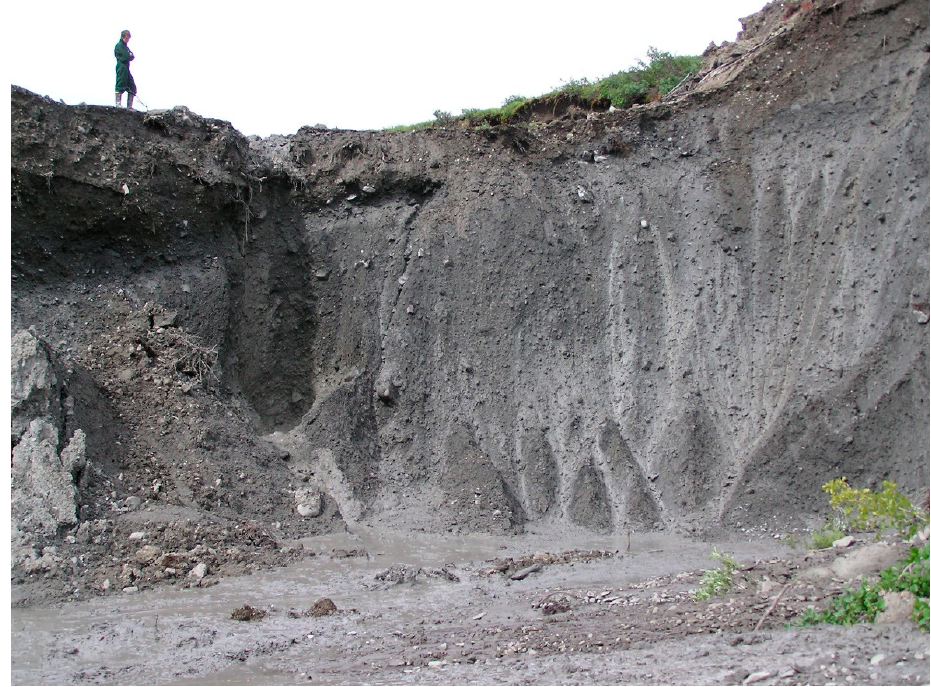
Figure 6. Exposure of the main scarp in slump NOAT265. The poorly sorted sediment in this exposure lacked obvious massive ice, but it contained enough ice to produce a zone of saturated mud at its base. Relict Pleistocene glacial ice has been observed in thaw slump escarpments at multiple locations in the Noatak Valley [13,14]. The total area of Pleistocene glacial drift mapped in the Noatak Valley [35,49] is about 2900 km 2 . Ice-cored glacial terrain is particularly vulnerable to change as a result of